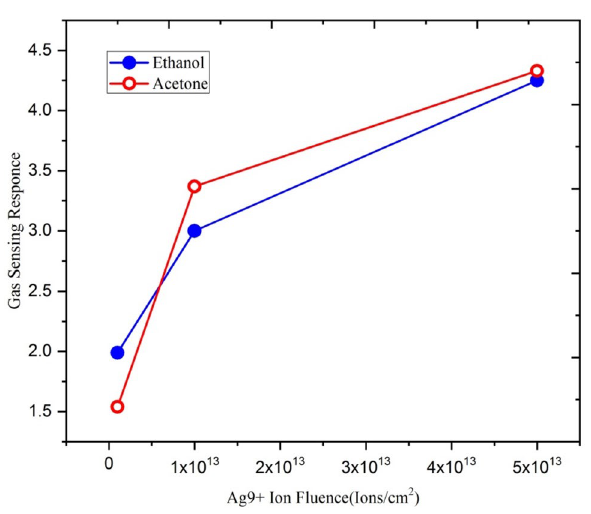
Figure 12. Variation of gas sensing response with different fluence of Ag 9+